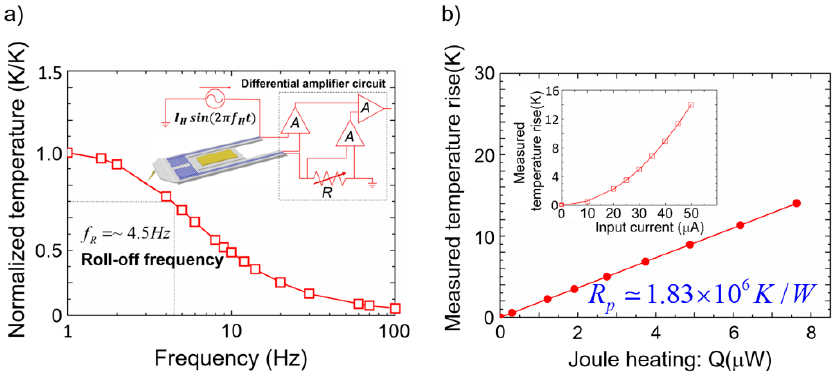
Figure 3. ( a ) Normalized measured temperature of the probe with varying frequency of the applied heat. Thermal response of the probe decreases as the frequency increases in accordance with the thermal time constant of the probe. Inset shows the schematic diagram of circuit for measuring the time constant and thermal resistance of the probe. Probe is heated through an AC power supply, and the normalized temperature is measured. Signal from the probe is amplified and detected using the amplifier circuit for precise measurement, and A and R are the amplifier and resistance, respectively. ( b ) Measured temperature rise according to the power applied to the probe (frequency of the applied voltage is fixed at 2 Hz.) Slope of the graph gives the thermal resistance of the probe ( R p ). Inset shows the input current-temperature graph.